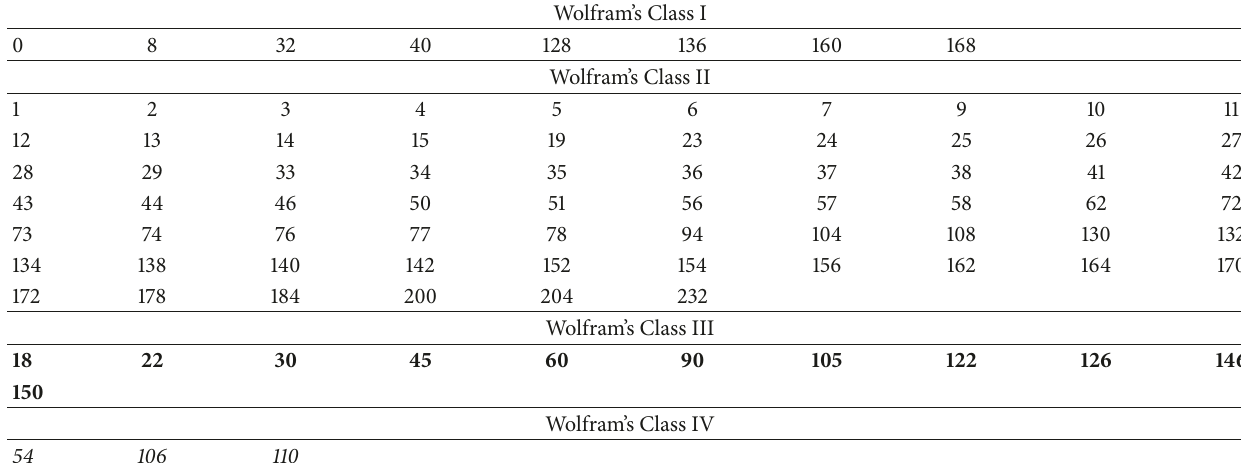
Table 1: Wolfram’s classification of ECA, with only the 88 rule equivalence classes shown (only the lowest number rule of a given equivalence class is listed)